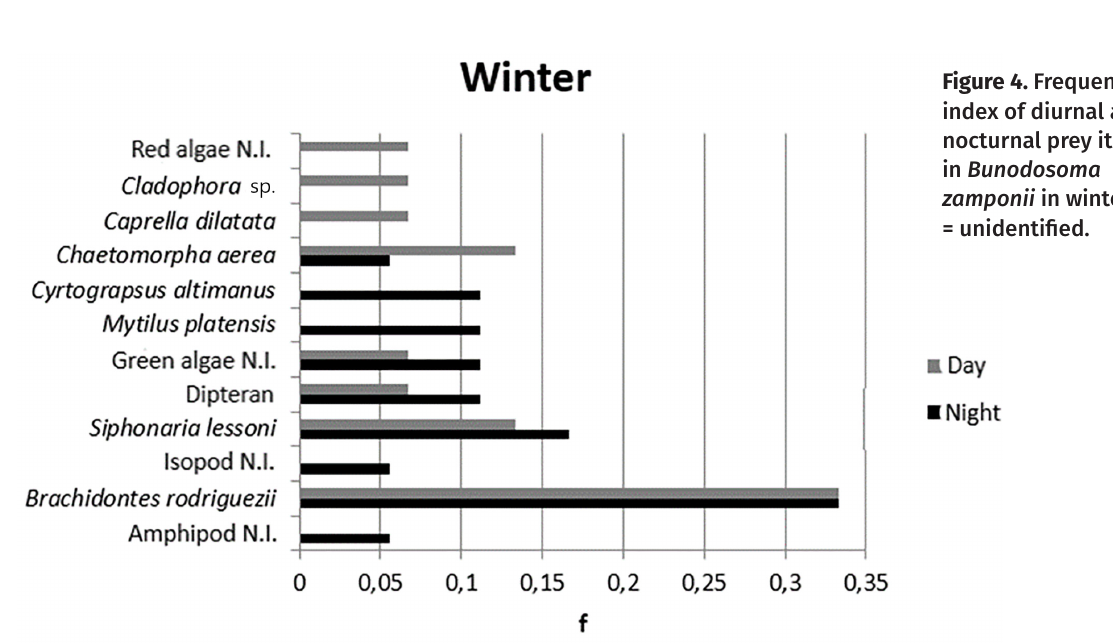
Figure 4. Frequency index of diurnal and nocturnal prey items in Bunodosoma zamponii in winter. N.I. =